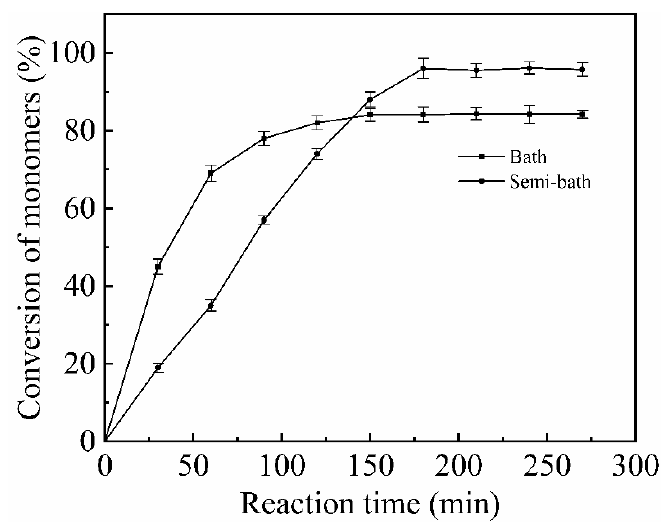
Figure 4. Effect of the polymerization method on the conversion of the monomer.